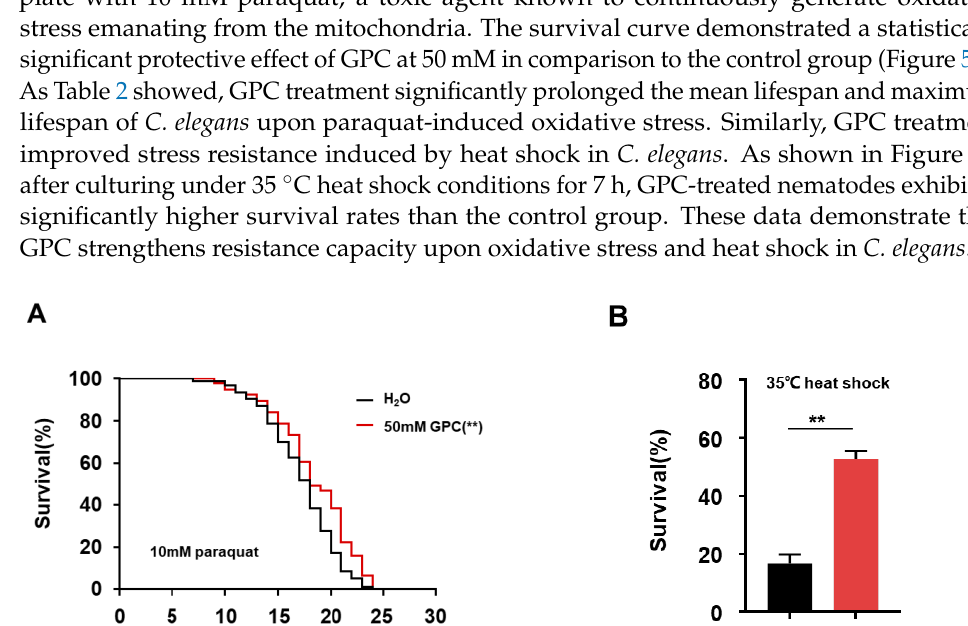
Table 2. Effect of GPC on the oxidative stress resistance in C. elegans .